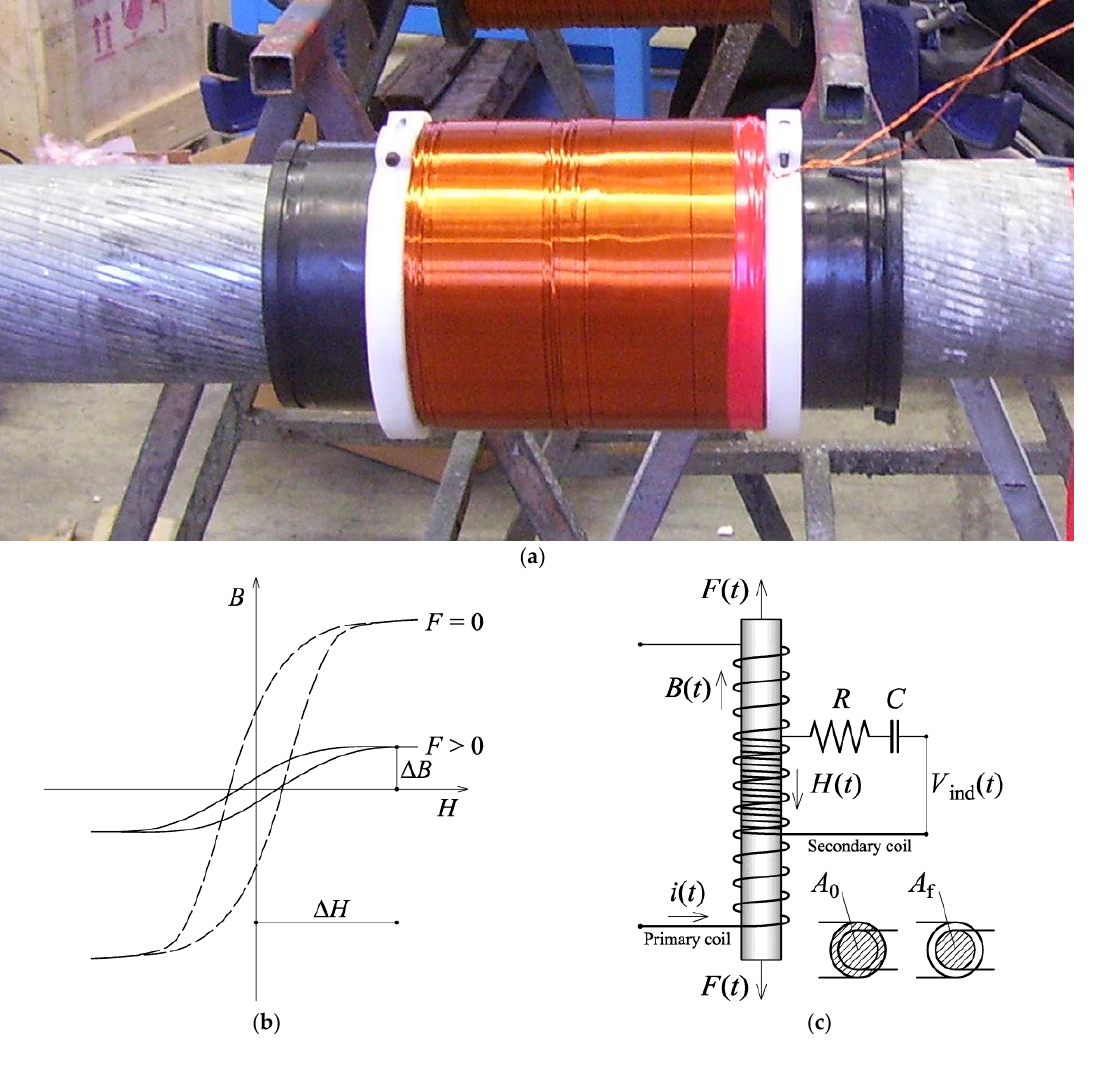
Figure 2. EM sensors: ( a ) picture of an EM sensor; ( b ) typical hysteresis loops for stressed and non-stressed ferromagnetic materials; ( c ) measurement principle.